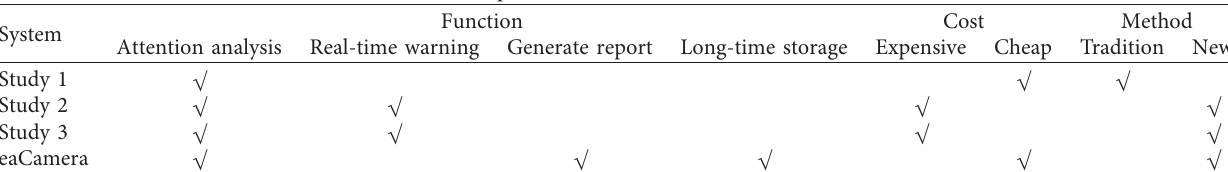
Table 1: Comparison of eaCamera with other